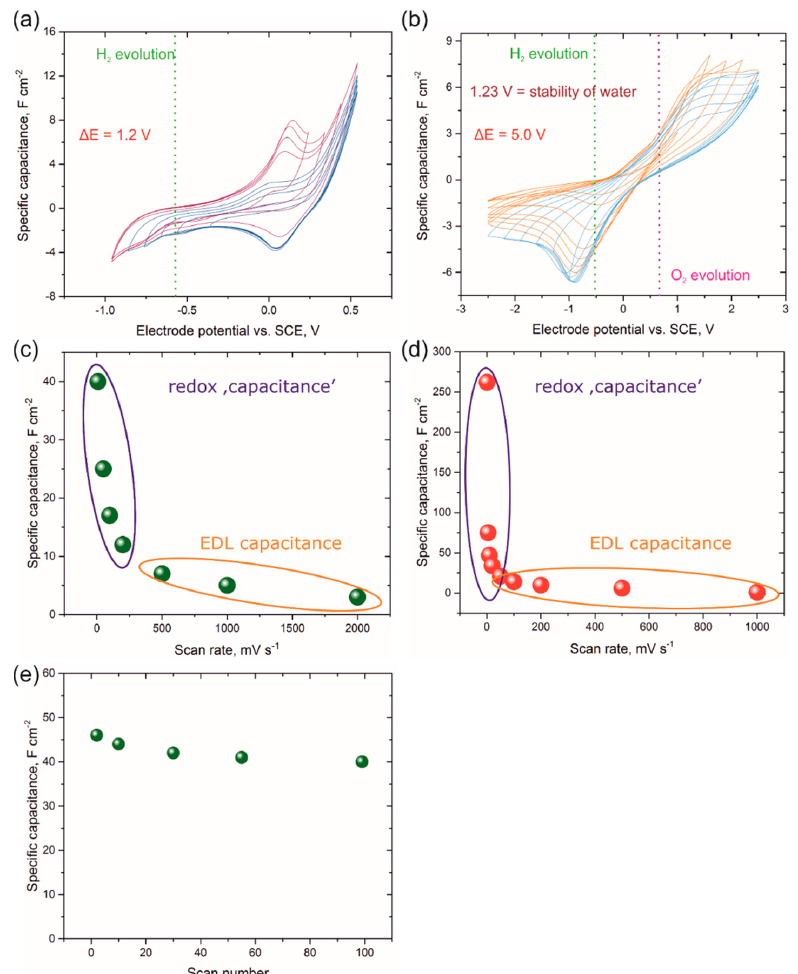
Figure 7. Three-electrode cyclic voltammetry scans (5 mV s − 1 ) on the PPy ( a ) and hybrid PPy-Ni(OH) 2 ( b ) nanowire array electrodes in a 1 M Li 2 SO 4 + 0.19 M 1,4-dihydroxybenzene aqueous solution with a gradual shift to negative and positive potential. A real capacitance as a function of scan rate for the PPy ( c ) and PPy-Ni(OH) 2 ( d ) nanowire array electrodes. The specific capacitance of the PPy nanowire array electrode vs. scan number dependence ( e